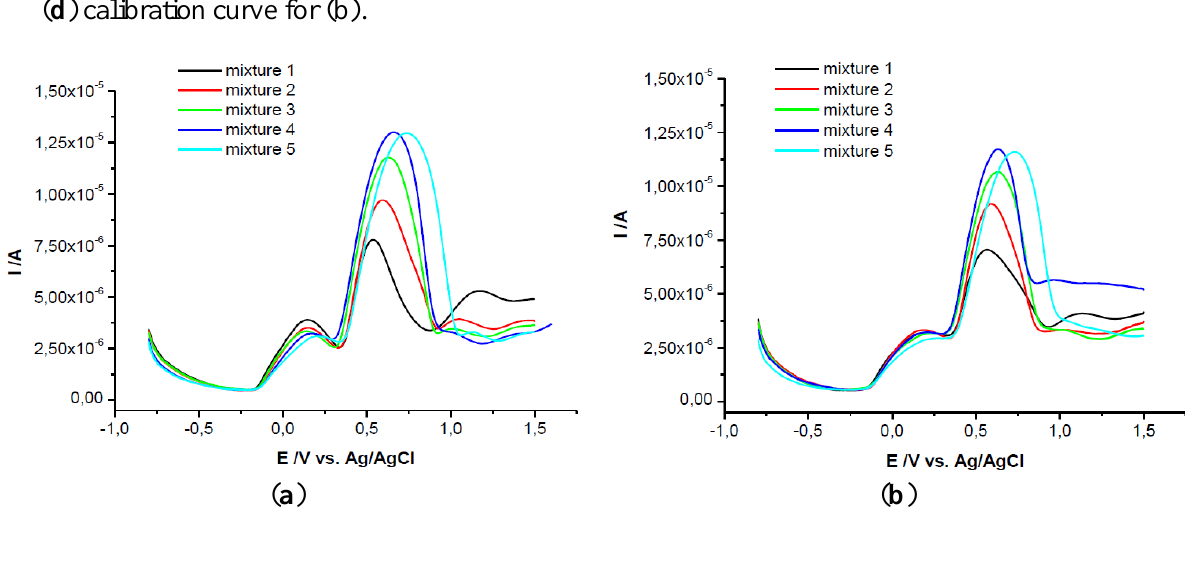
(b) At Constant Concentration of AA (10 −3 M).